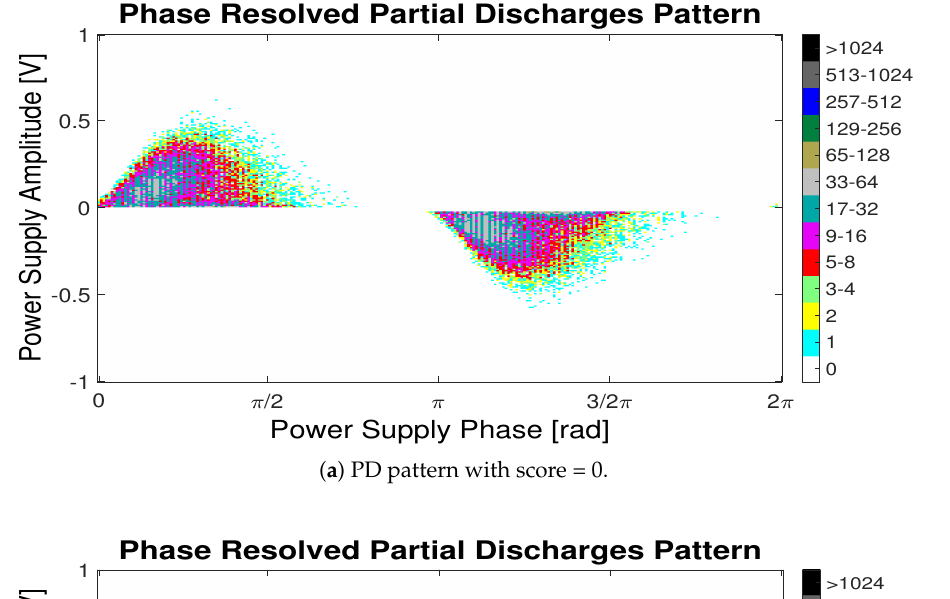
( a ) PD pattern with score = 0.